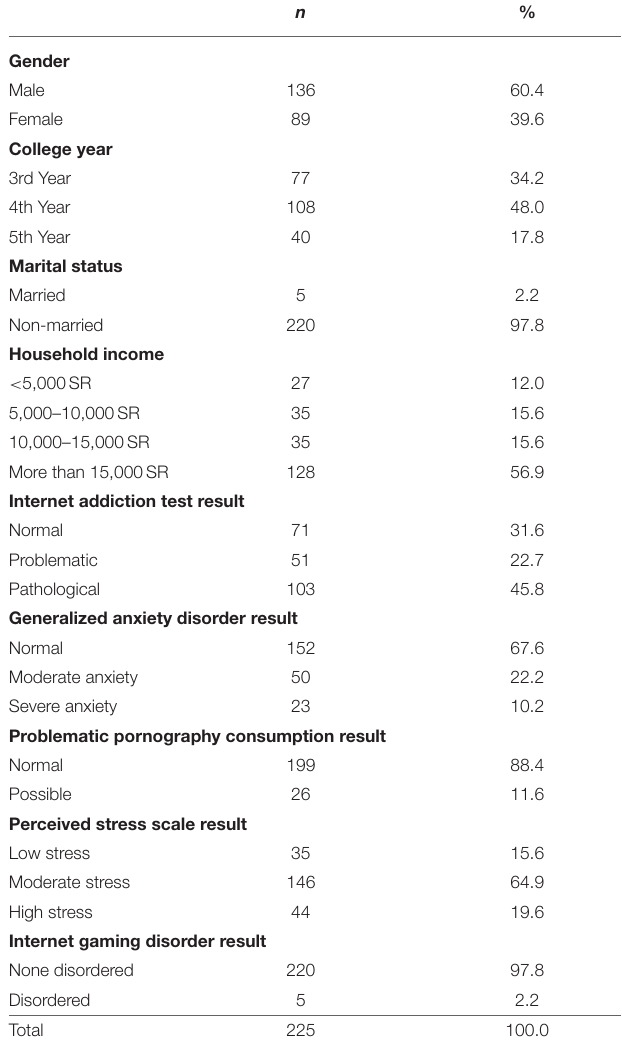
TABLE 1 | Demographics and prevalence of